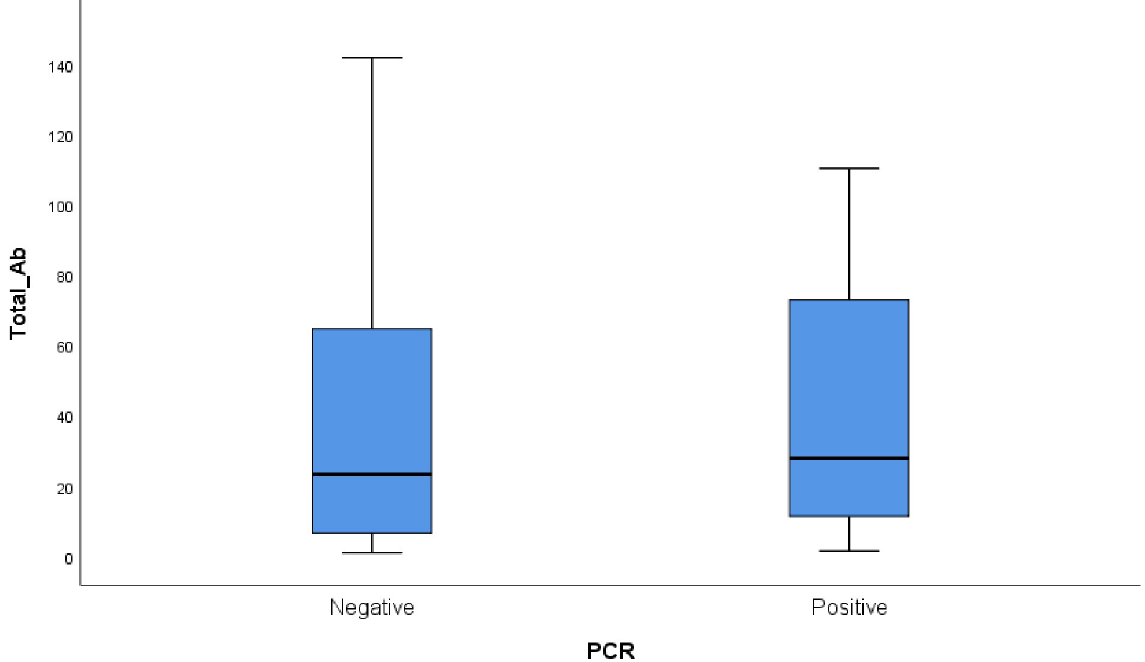
Fig 1. Box plot of antibody level in the positively tested antibody group.